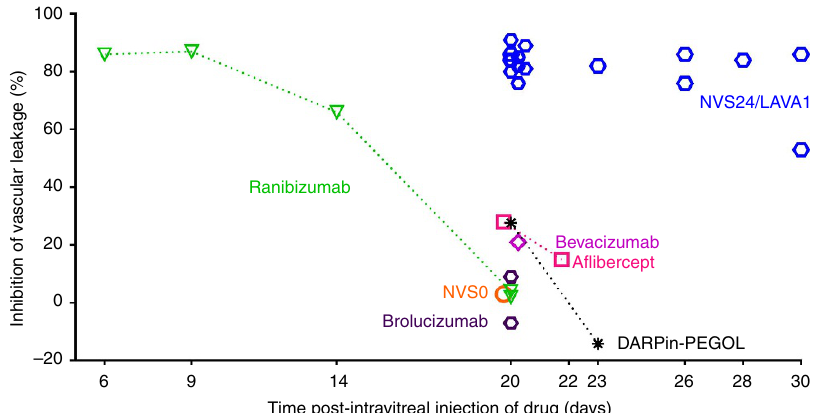
Figure 2 | Duration of activity of anti-VEGF molecules in the rabbit retinal leakage model. Two days before fluorescein angiography, retinal vessel permeability was induced by an intravitreal injection of 10pmol per eye hVEGF-A 165 . hVEGF-induced fluorescein leakage was measured in six to eight rabbit eyes for each anti-VEGF molecule and compared with control eyes that received intravitreal hVEGF but no anti-VEGF molecule. Each data point represents the average inhibition of vascular leakage compared with controls. LAVA1 inhibited fluorescein leakage when administered up to 28 days prior the hVEGF challenge (30 days before fluorescein angiography), whereas equimolar doses of ranibizumab, bevacizumab, aflibercept, brolucizumab or DARPin-PEGOL did not substantially inhibit fluorescein leakage when administered 18–21 days before the hVEGF challenge (20–23 days before fluorescein angiography). Data shown are from several independent